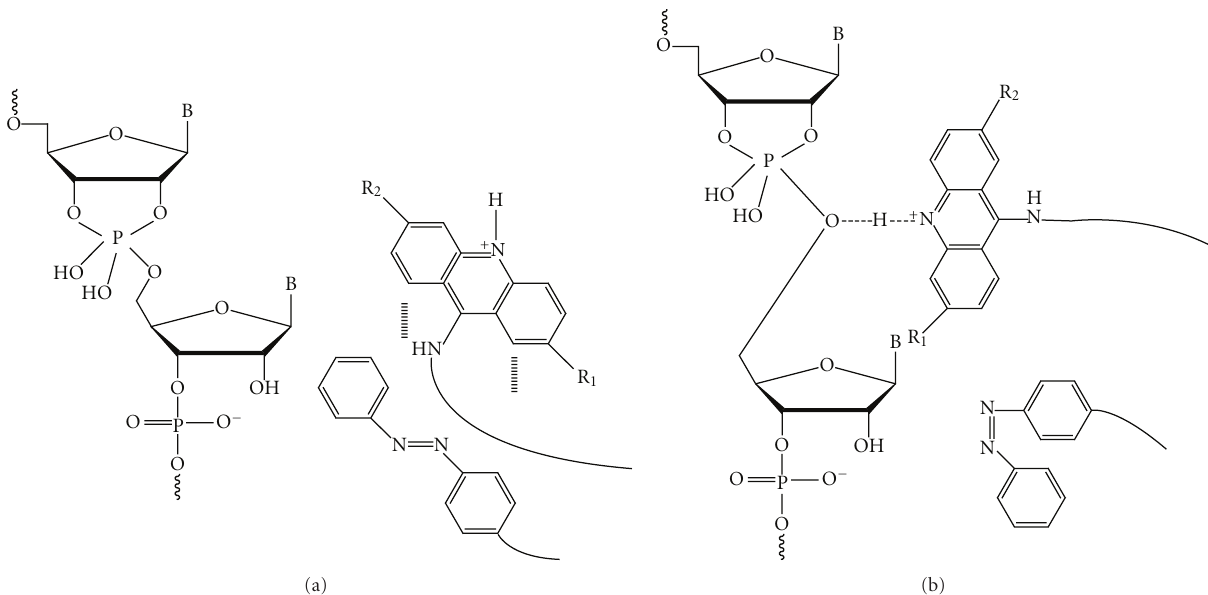
Figure 7: A proposed mechanism of the Photoswitching of site-selective RNA scission by azobenzene residues. (a) Azobenzene residues in trans form stack on the acridine in the adjacent residue and e ffi ciently inhibit site-selective RNA activation. (b) When the solution is irradiated with UV light and the azobenzene isomerizes into cis isomer, the acridine is released from stacking and the cleavage reaction is significantly